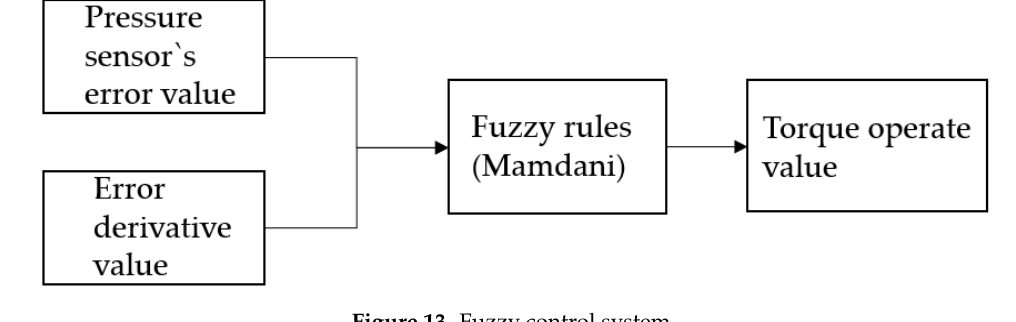
Figure 13. Fuzzy control system.